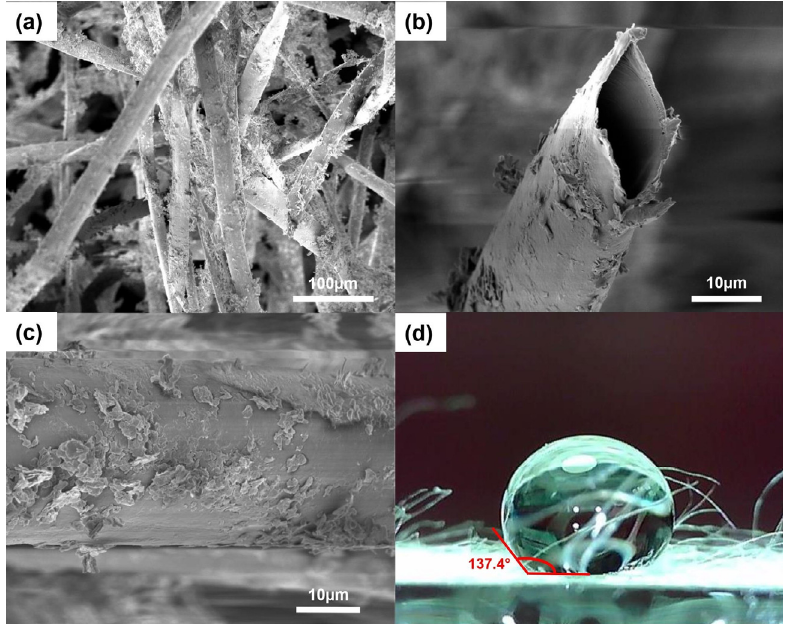
Figure 1. (Color online) SEM images of ( a ) CaSt 2 -KF at low magnification (300×), ( b ) its cross-section and ( c ) surface at high magnification (2000×), and ( d ) CaSt 2 -KF’s static water contact angle measure-